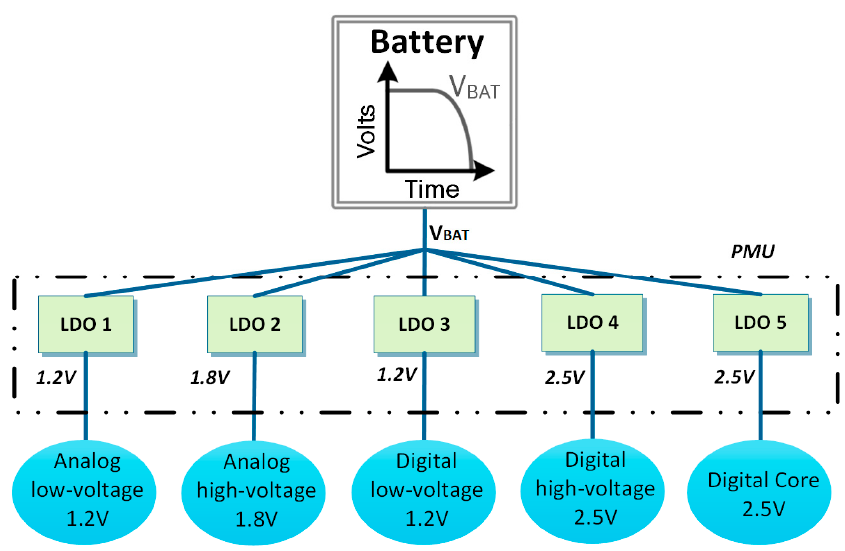
Figure 1. Power management system using multiple LDOs (low dropout).